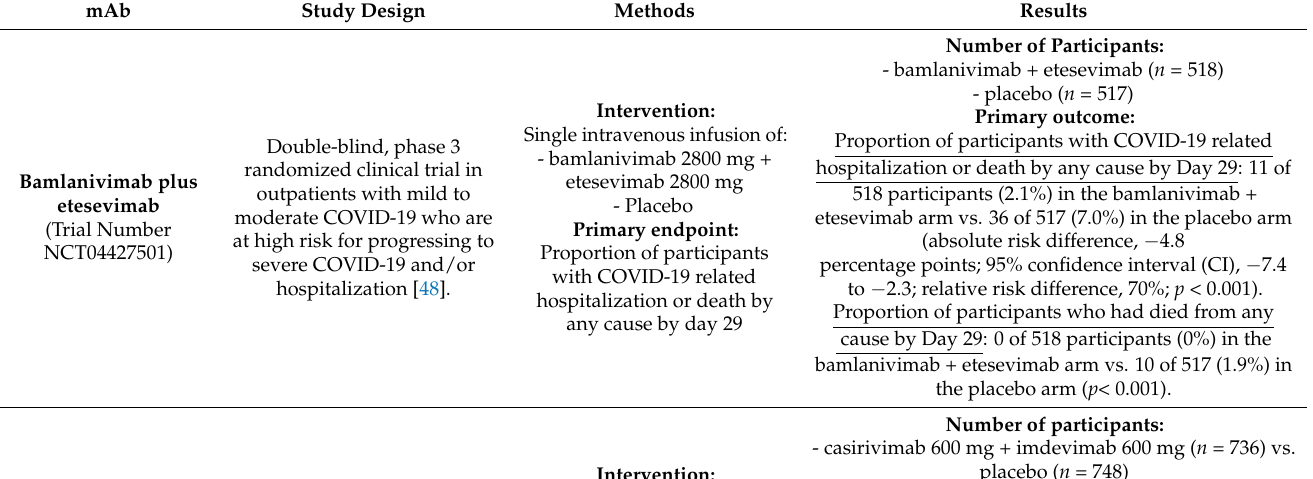
Table 2. Randomized clinical trials supporting mAbs approved by FDA EUAs. mAb Study Design Methods